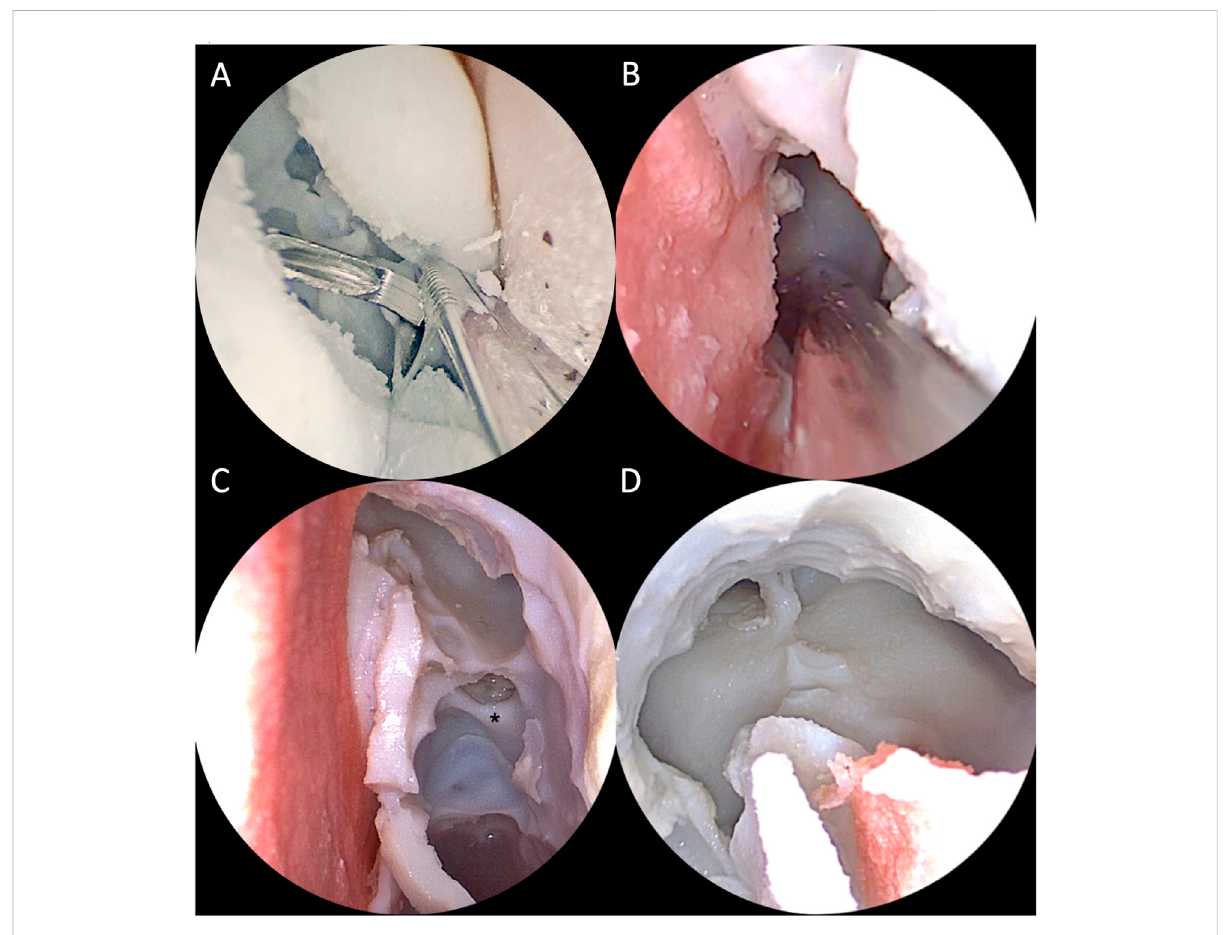
FIGURE 14 Intraoperative view of simulated endoscopic sinus surgery steps on the 3D printed model. (A) Right middle meatal antrostomy with backbiter forceps; (B) Left paraseptal sphenoidotomy; (C) Left approach to the frontal sinus with a 30 ° optic. The middle turbinate has been removed and the anterior skull base exposed. The black asterisk indicates the anterior ethmoidal artery canal. (D) Final view after completion of DRAF III procedure from the right nasal cavity with a 30 °